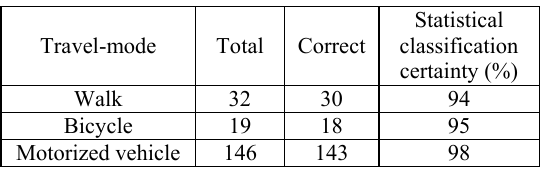
Table 1. Classification results for the first stage